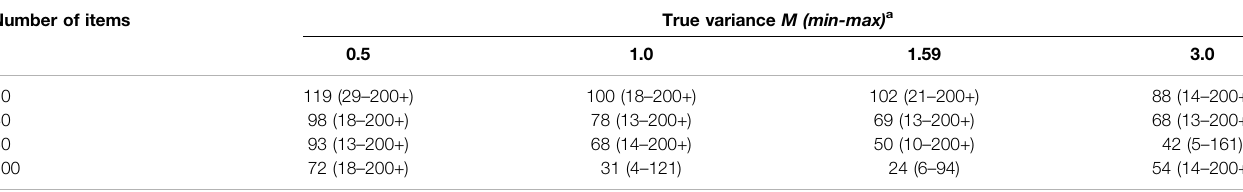
TABLE 2 | Mean number of comparisons per item required for accurate estimation of the true variance. Number of